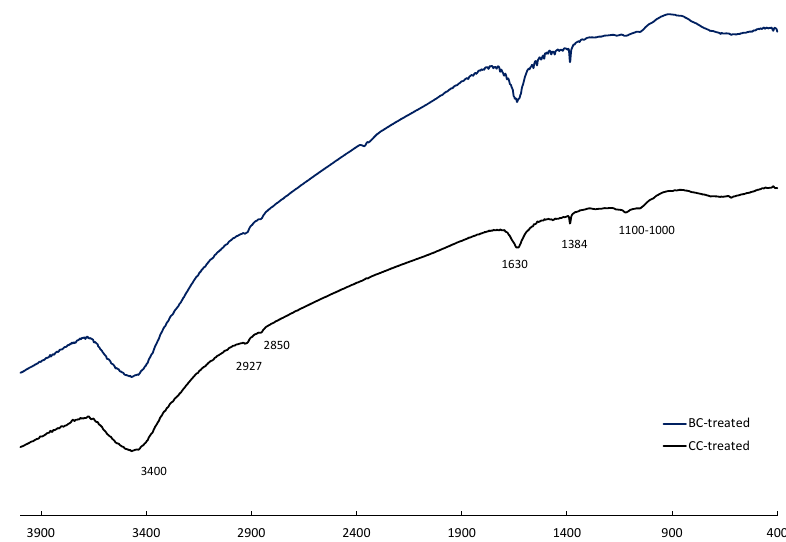
Figure 5. FTIR spectra of carbon materials after treatment with leaching solution (CCt and BCt).